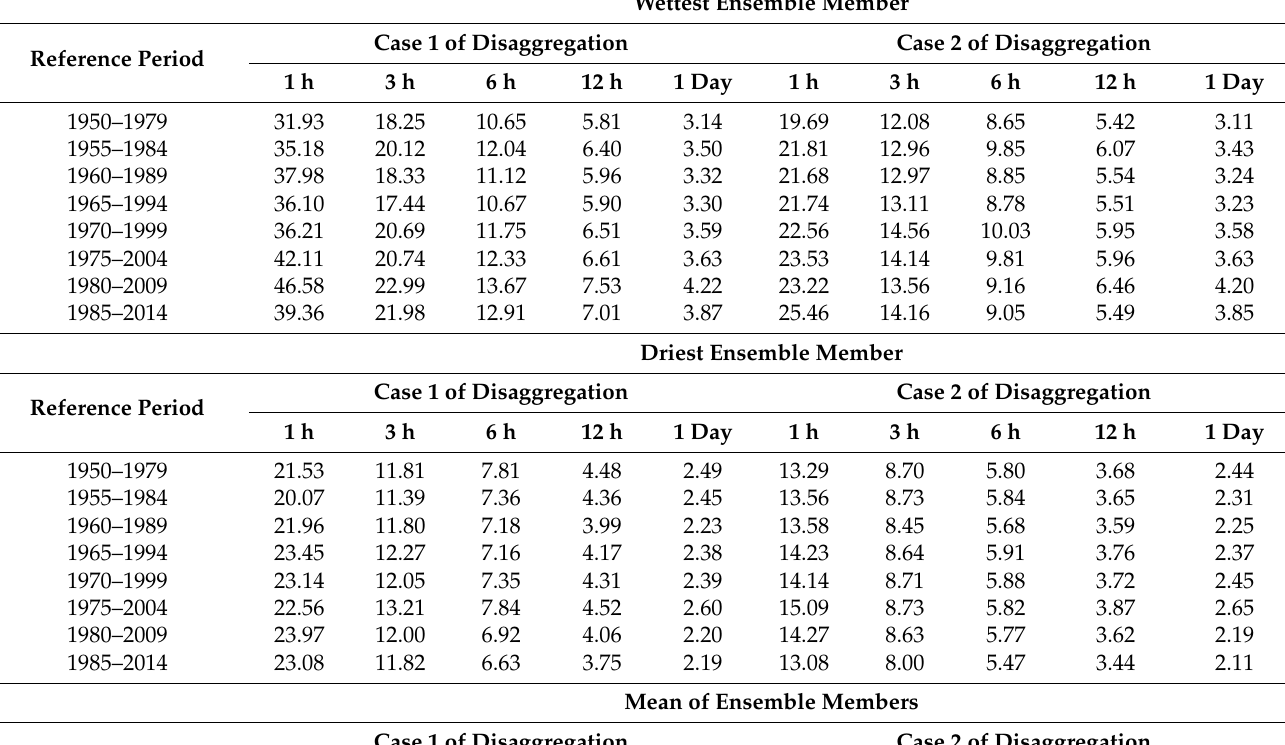
Table 2. The projected future rainfall intensity for 10-year return period, 5 rainfall durations, 8 reference periods, 2 cases of rainfall disaggregation, and for the driest ensemble member, wettest ensemble member, and the mean of the 11 RCM ensemble